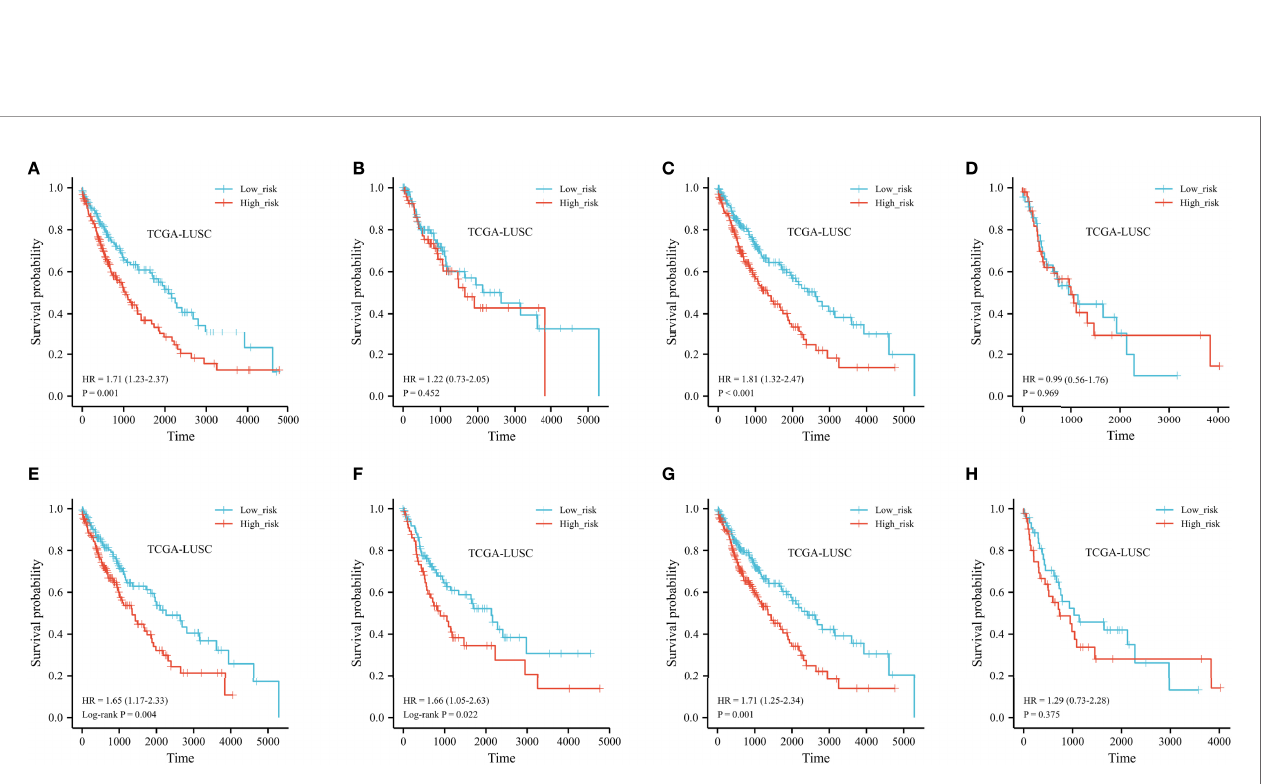
FIGURE 7 | Kaplan – Meier curve of strati fi ed analyses of the FRG prognostic signature for associations with clinical characteristics. (A) OS curve in patients older than 65 years old. (B) OS curve in patients younger than 65 years old. (C) OS curve in the T1+T2 stage. (D) OS curve in the T1+T2 stage. (E) OS curve in the N0 stage. (F) OS curve in the N+ stage. (G) OS curve in stage I + stage II. (H) OS curve in stage III + stage IV.